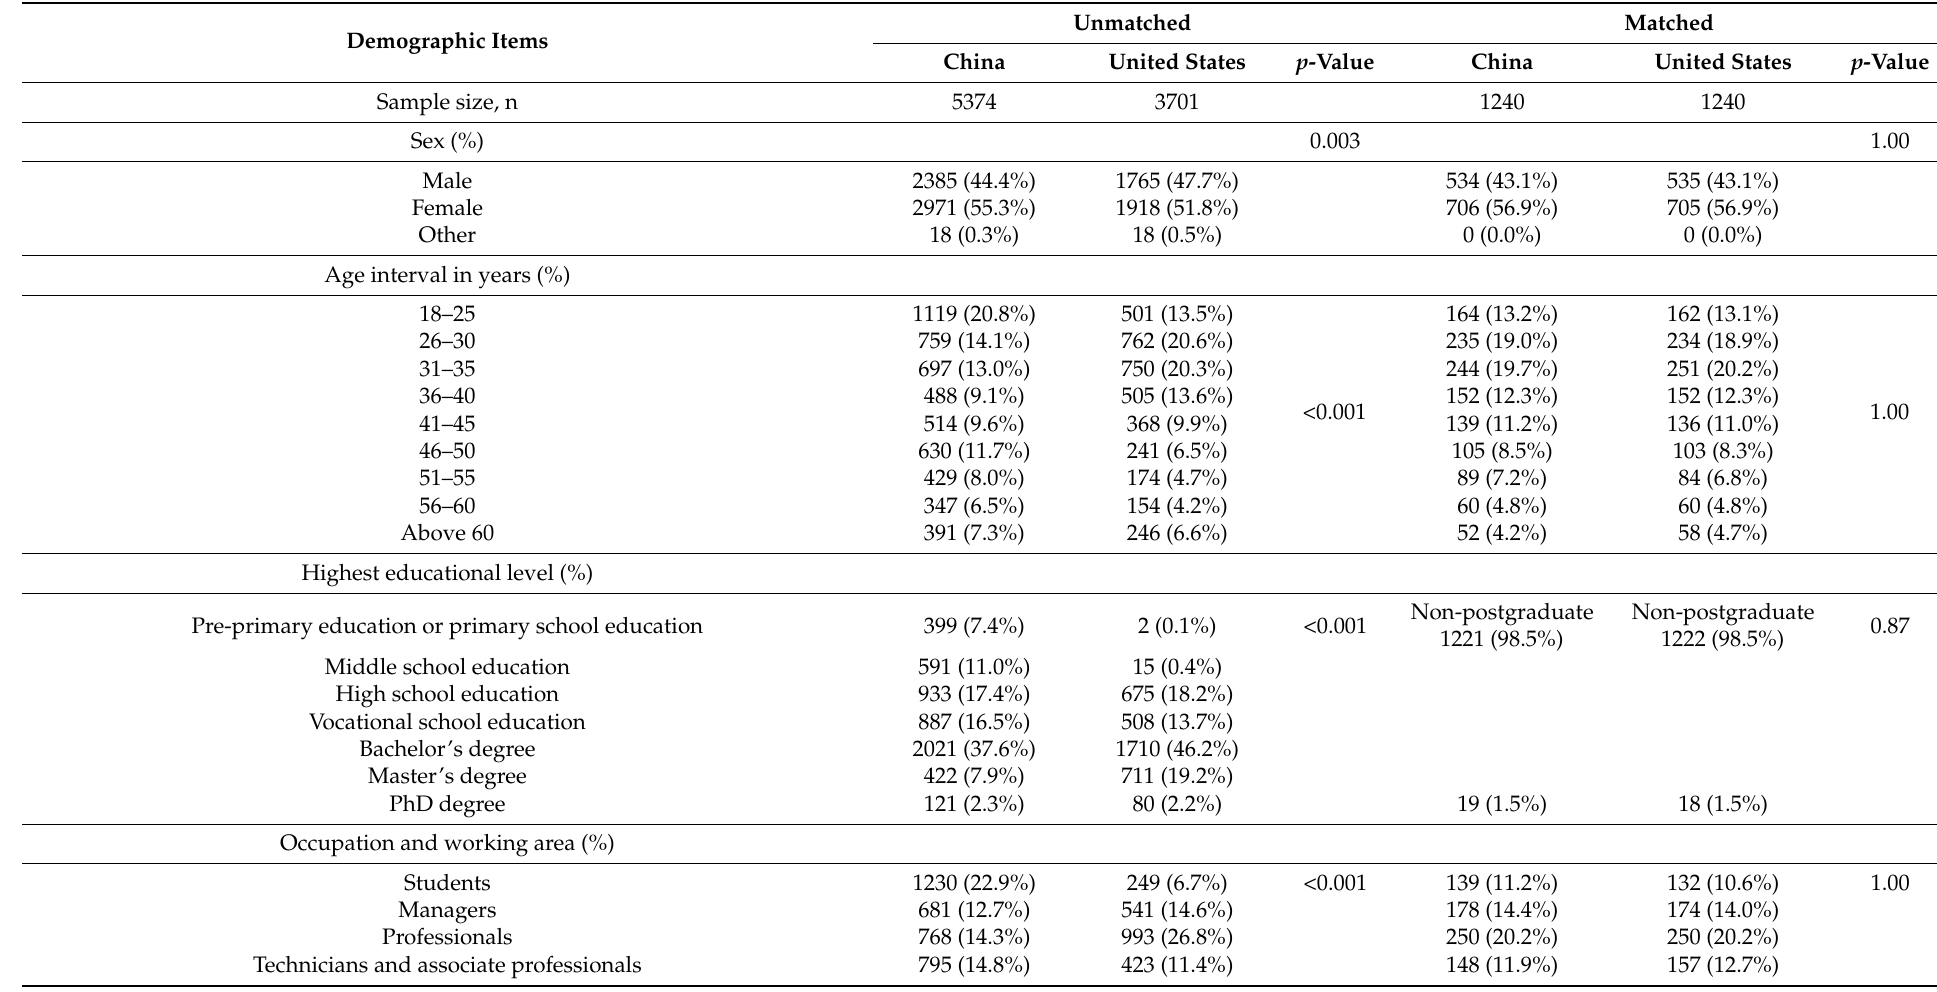
Table 1. Participants’ demographic information, a major source of information and